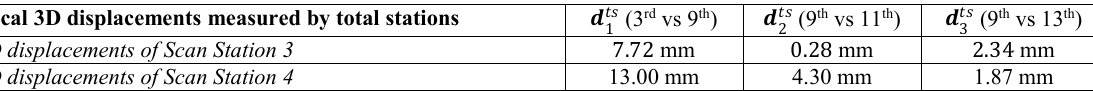
Figure 4. Std. devs. of representative points from data set collected on the 9 th Decem ber 2016. The colour pattern represents the std. devs. that vary from 0 to 1